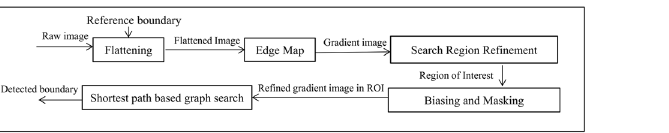
Fig 2. OCTRIMA 3D framework to detect each intraretinal layer boundary using the shortest-path based graph search